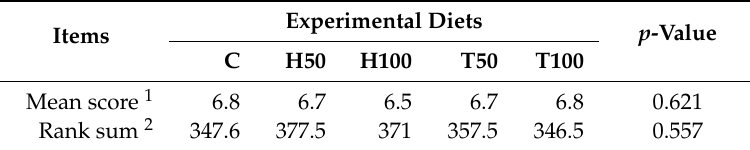
Table 6. Overall acceptability mean values and rank-sum scores.